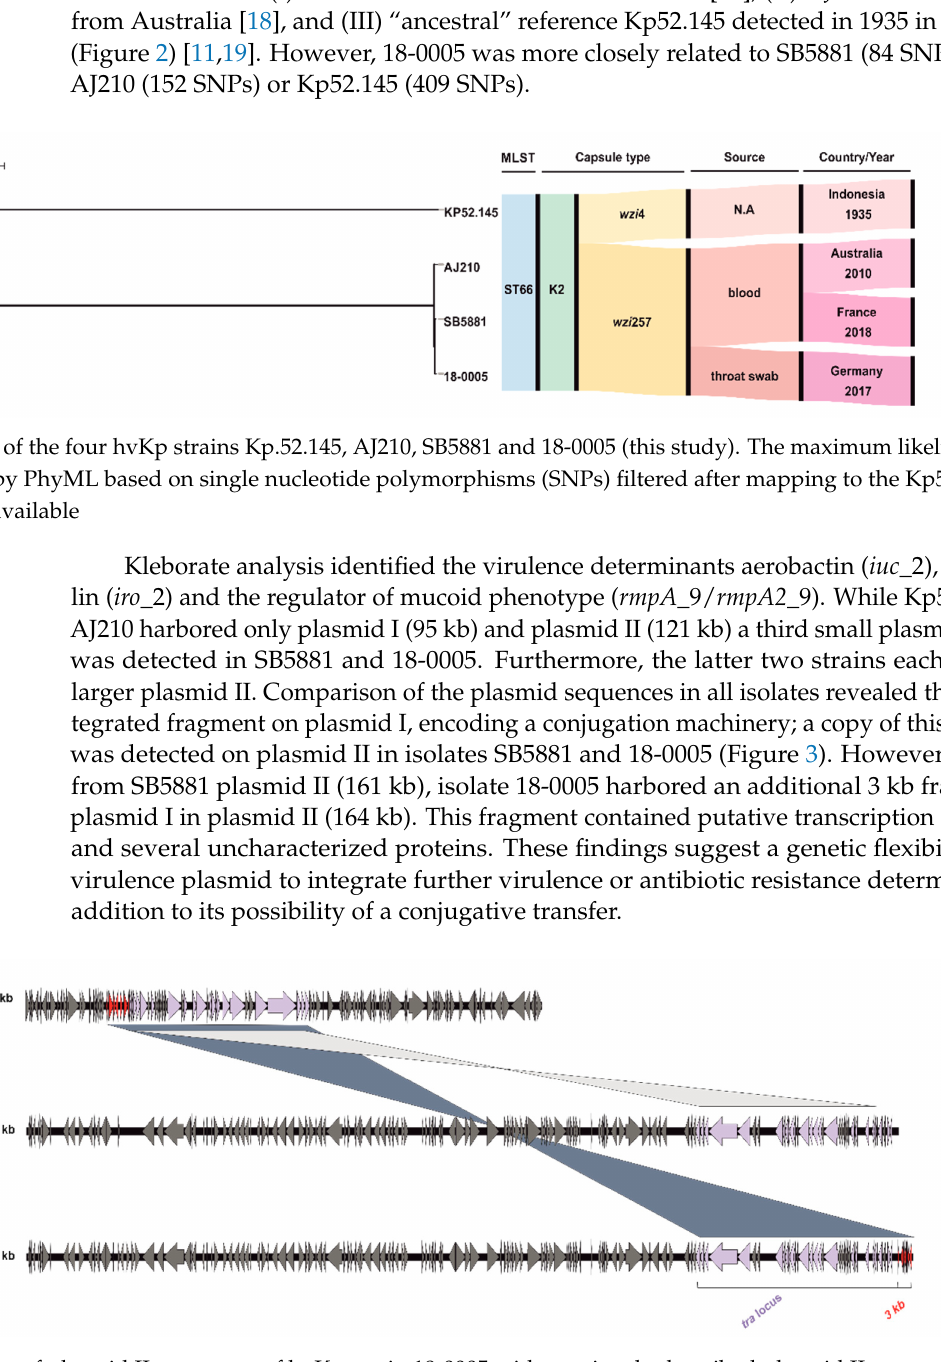
Figure 3. Comparison of plasmid II sequences of hvKp strain 18-0005 with previously described plasmid II sequences of strain SB5881 and reference strain Kp52.145 (plasmid I). Based on a pairwise BLAST analysis (blastn) of the sequences and visualized by the program Easyfig (v.2.2.2). ORFs are illustrated as arrows. The shared tra locus (light purple) and the new integrated 3 kb fragment (red) are